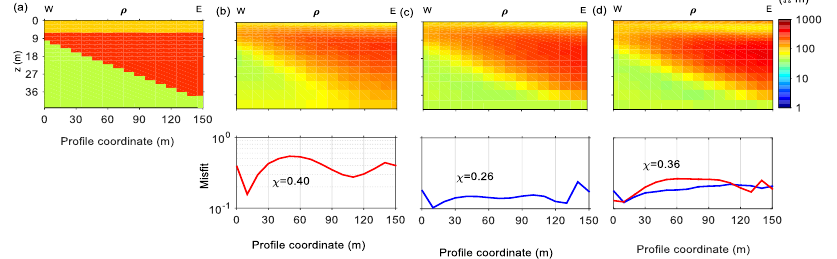
Figure 8. Comparison between the true resistivity value ( a ) and resistivity inversion results of the non-IP responses of the strong chargeable medium: by x -data only ( b ); z -data only ( c ); and x and z data ( d ). The meanings of the curves and the area are the same as in Figure 7.